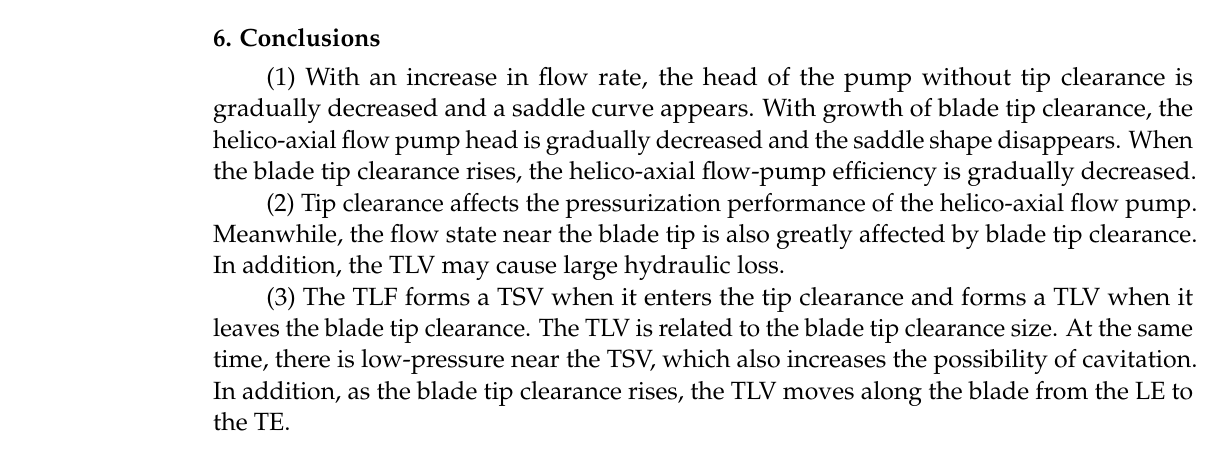
Figure 16. Streamlines on latter part.